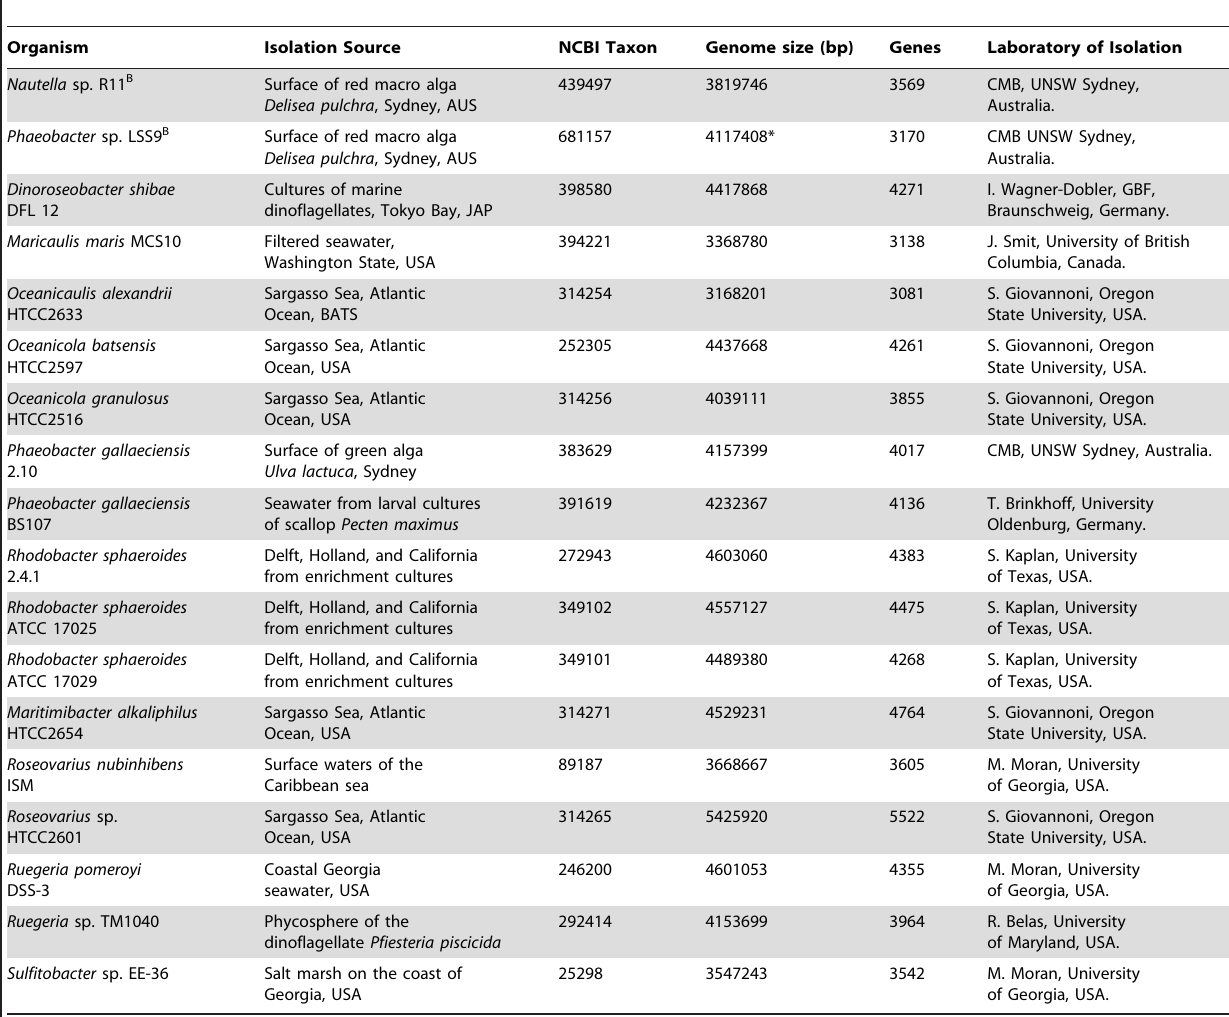
Table 1. Roseobacter-affiliated strains screened for the ability to cause bleaching and used for comparative genomics (* estimated genome size; B indicates strains with ability to cause